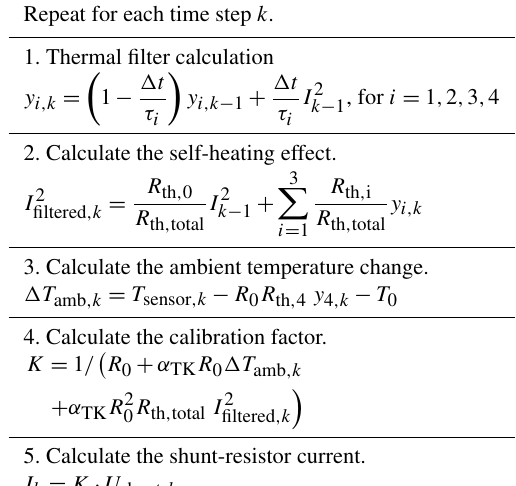
Table 2. Algorithm: discrete-time dynamic error correction proce- dure. Repeat for each time step k